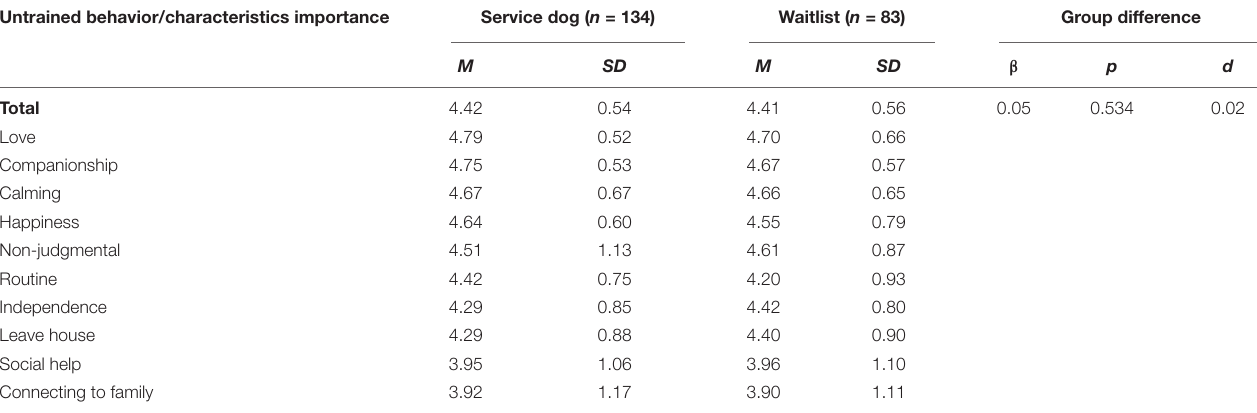
TABLE 3 | Means and standard deviations of the expected and experienced importance for PTSD symptoms (1 = Not at all important to 5 = Extremely important) of untrained service dog behaviors, ordered from highest to lowest values within each group. Untrained behavior/characteristics importance Service dog ( n =